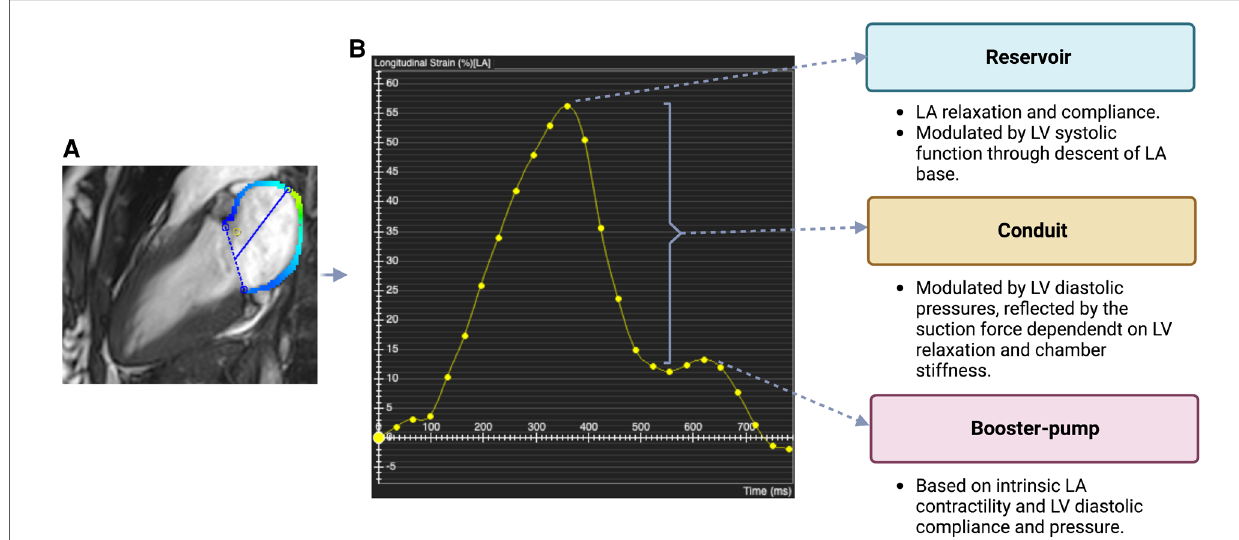
FIGURE 1 Phases of Atrial Function ( A ) cardiac magnetic resonance (CMR) long-axis 2-chamber view. Colored line (blue/green) represents the myocardial border of the left atrium (LA) where strain is measured. Dashed line and straight line mark LA width and length, respectively. The CMR image was acquired using a 3 T CMR scanner from our institute (St Vincent ’ s Hospital Sydney, Australia) with ethics approval. ( B ) Line graph plotting global longitudinal LA strain (%) in 25 different points of the cardiac cycle (yellow dots). Reservoir strain=maximal value of the fi rst (diastolic) peak; booster-pump strain=maximal value of the second (systolic) peak; conduit strain=difference between reservoir strain and booster-pump strain. LA and left ventricular (LV) factors that contribute to strain in each of these phases are